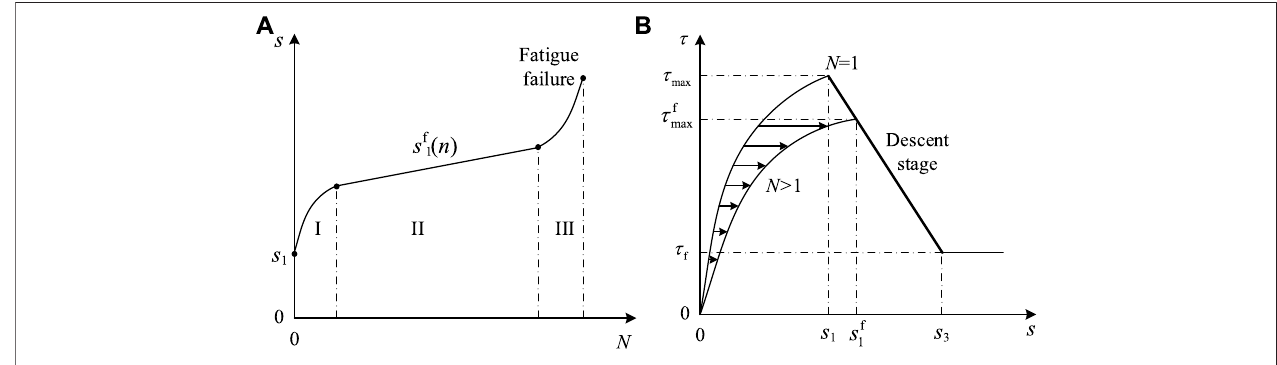
FIGURE 2 | Bond behavior of reinforcing bars: (A) variation curve of slip with repeated cycles and (B) bond – slip relationship under fatigue loading.